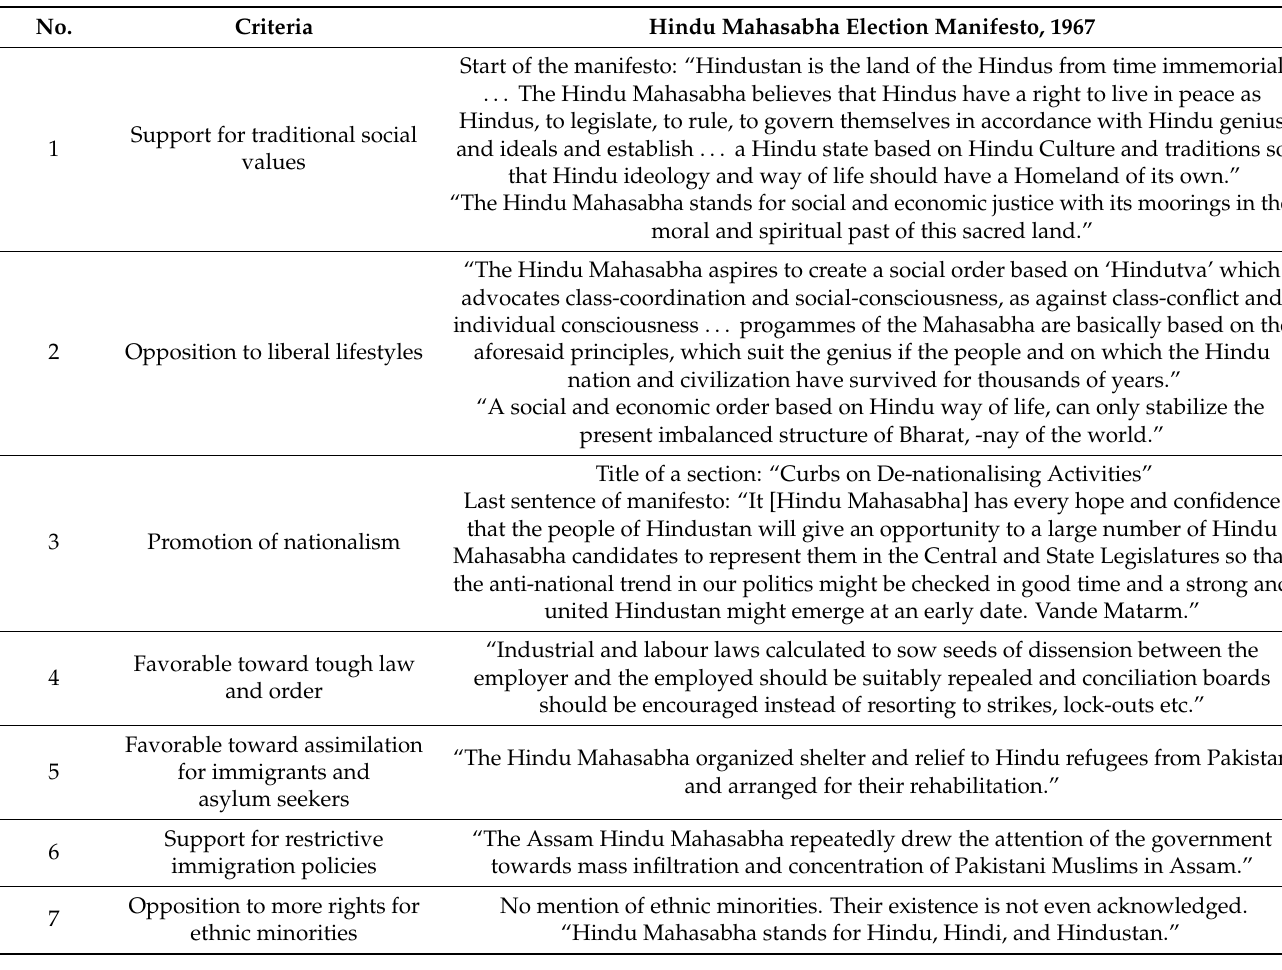
Table 1. Hindu nationalism and populism in Hindu Mahasabha based on 1967 manifesto (Hindu Mahasabha